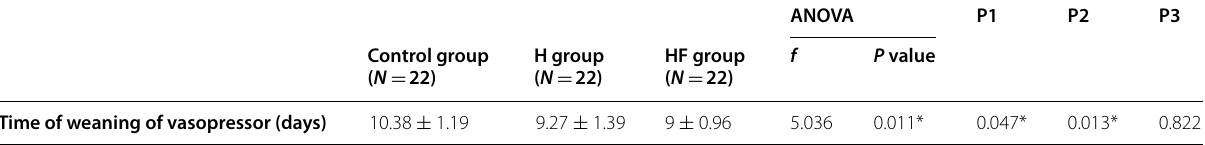
Table 2 Comparison between the three groups regarding the time to wean from